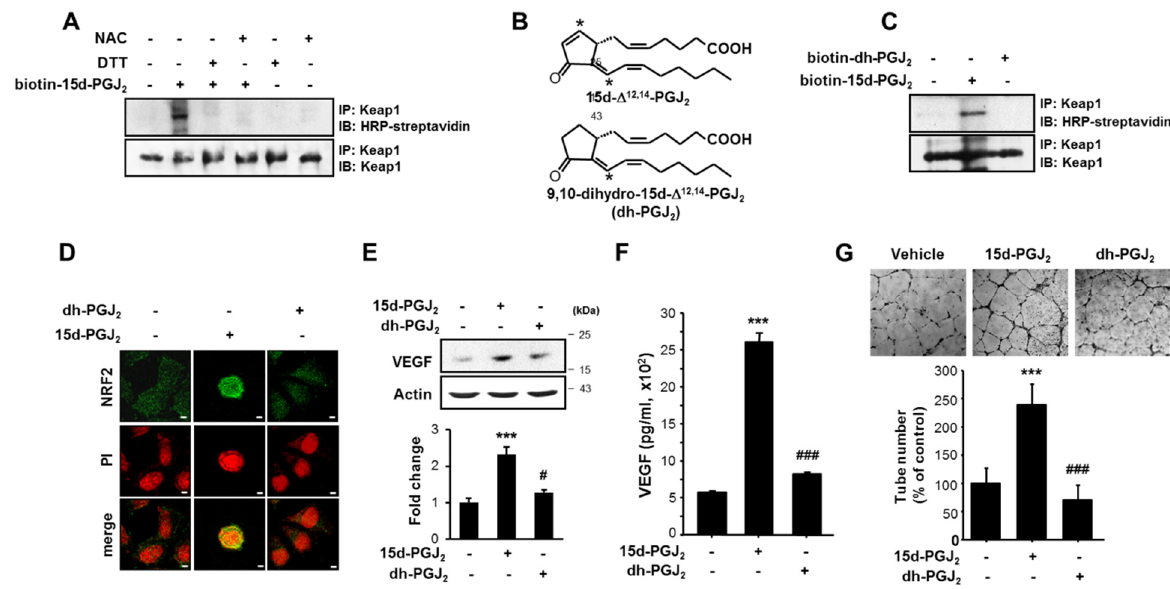
Figure 4. The α , β -unsaturated carbonyl moiety of 15d-PGJ 2 is essential for the activation of NRF2, expression/production of VEGF, and further angiogenesis induced by this cyclopentenone prostaglandin. ( A ) MCF-7 cells were incubated with 30 µ M of biotinylated 15d-PGJ 2 in the presence of dithiothreitiol (DTT) (1 mM) and N-acetylcysteine (NAC) (5 mM) for 9 h. The interaction between Keap1 and 15d-PGJ 2 was assessed by immunoblot analysis, and the incorporation of biotinylated 15d-PGJ 2 into Keap1 immunoprecipitates was detected with horseradish peroxidase (HRP)-streptavidin and enhanced chemiluminescence (ECL). ( B ) The chemical structures of 15d-PGJ 2 and biotinylated 9,10-dihydro-15d-PGJ 2 (dh-PGJ 2 ). Asterisks depict electrophilic carbons (position 9 and 13). ( C ) MCF-7 cells were incubated with 30 µ M of biotinylated 15d-PGJ 2 or biotinylated dh-PGJ 2 . The interaction between Keap1 and 15d-PGJ 2 or dh-PGJ 2 was assessed by immunoblot analysis with HRP-streptavidin and ECL. ( D ) Immunocytochemical analysis was performed using anti-NRF2 antibody after the treatment of MCF-7 cells with 30 µ M each of 15d-PGJ 2 and dh-PGJ 2 for 12 h. Scale bars indicate 50 µ m. Western blot analysis ( E ) and ELISA ( F ) and were performed to examine the levels of VEGF in MCF-7 cell treated with 15d-PGJ 2 or dh-PGJ 2 . Data are means ± SD. *** p < 0.001, significantly different compared to vehicle control; # p < 0.05 and ### p < 0.001, significantly different compared to 15d-PGJ 2 -treated cells. ( G ) HUVECs were treated with various conditioned media (CM) with 10% fetal bovine serum (FBS). After 16 h incubation with 15d-PGJ 2 and dh-PGJ 2 , microphotographs were taken 40 × . Representative endothelial tubes were shown. Tube formation (%) was quantified by the number of three-way branching point. Values are means ± SD of three independent experiments. *** p < 0.001, significantly different from vehicle control; ### p < 0.001, significantly different compared to 15d-PGJ 2 -treated